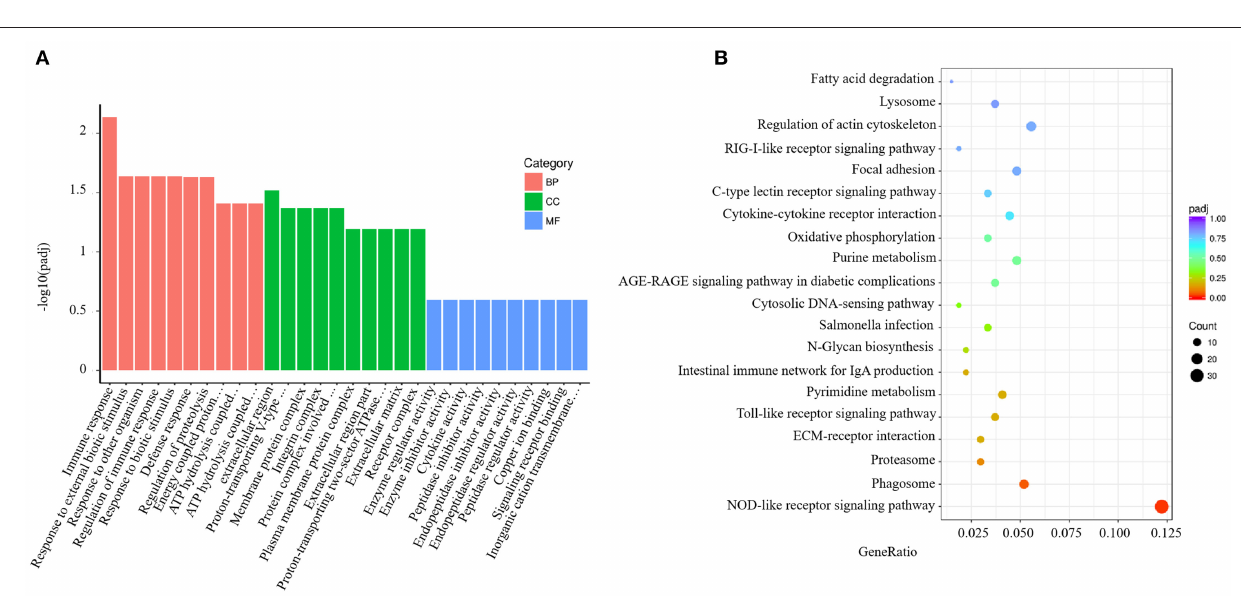
FIGURE 1 | DEGs identified in the spleen infected by V. harveyi . The number of DEGs in spleen is shown in (A) , and the volcano plot of DEGs in spleen is shown in (B) .